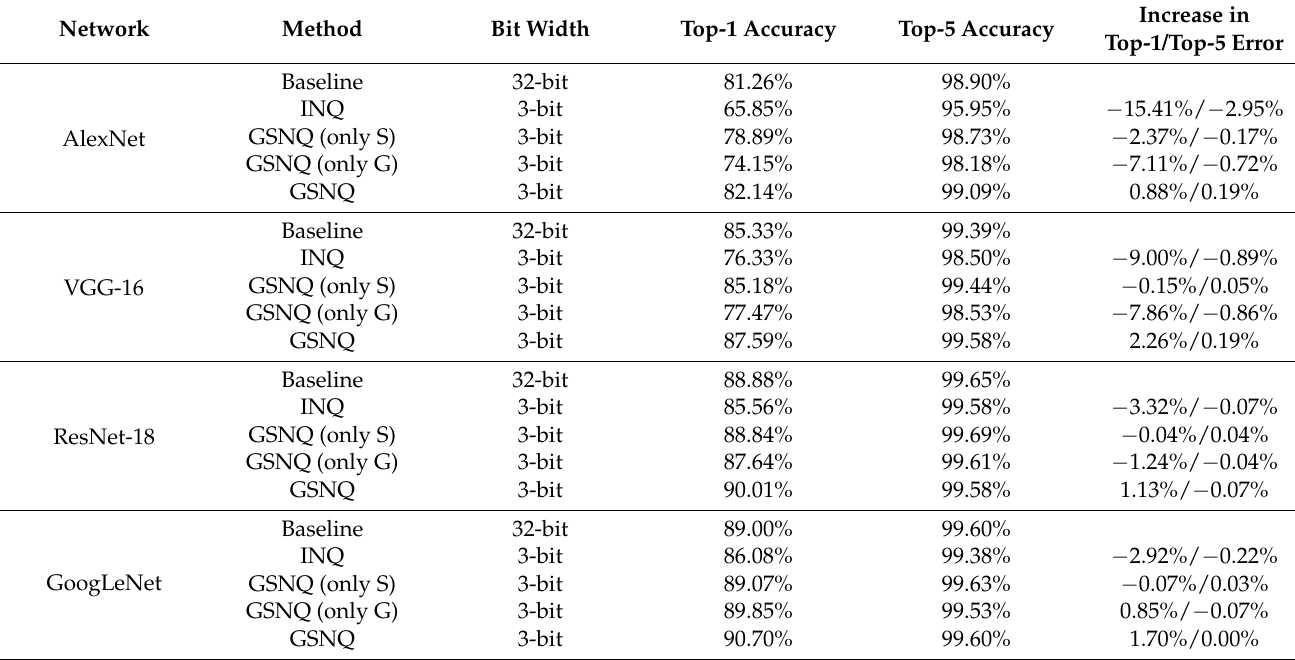
Table 6. Ablation experiments on 3-bit quantization on the CIFAR10 dataset.